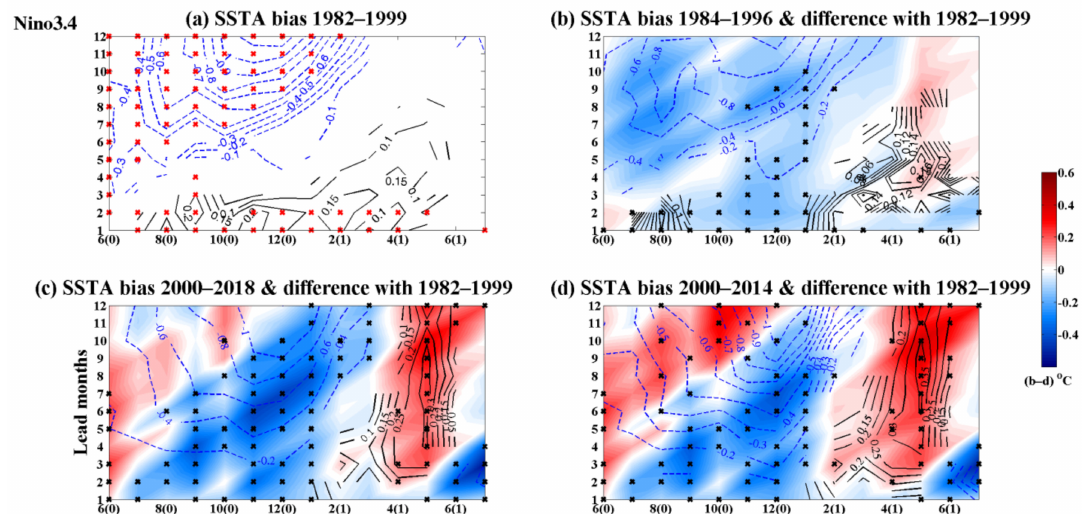
Figure 7. ( a ) Composite sea surface temperature anomalies (SSTA) bias in the MME forecasts during 1982–1999 as a function of the target months and lead months for the Niño3.4 index of El Niño evolution (the contour is in units of ◦ C, the blue dashed lines show the negative SSTA bias, and the black solid lines show the positive SSTA bias). ( b – d ) SSTA bias for the periods shown in each subtitle and its difference with 1982–1999 (shading in units of ◦ C, and the contours are the SSTA bias during 1984–1996, 2000–2018, and 2000–2014)). The time abscissa is from June of the El Niño developing year to July of the El Niño decaying year. Note: the crosses indicate that the signs of the MME SSTA bias are the same for all five individual models.